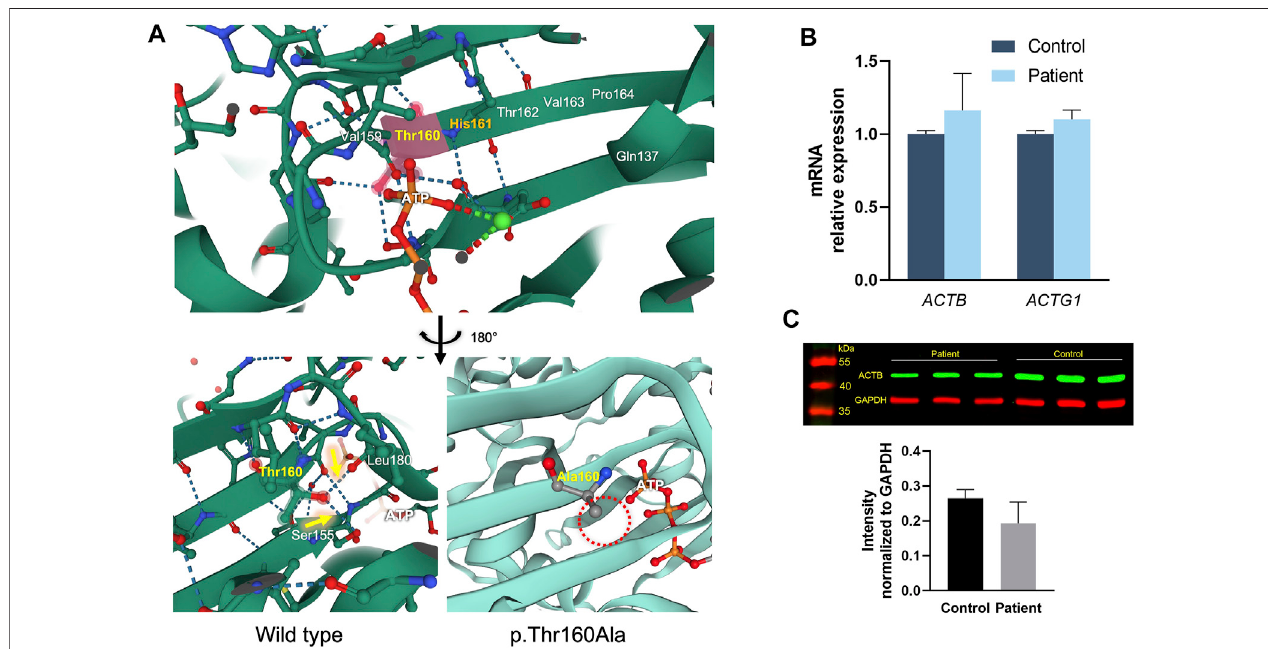
FIGURE4| ACTBproteinstructureandvariantmodeling,andexpression analysis. (A) Thr160isclosetoHis161,whichisthecatalyticbaseofATPhydrolysis. The hydroxyl group side chain of Thr160 forms hydrogen bonds with the spatially close Leu180 and Ser155 (yellow arrows), and the p.Thr160Ala variant results in alanine without a hydroxyl group in the side chain, which cannot form hydrogen bonds with the surrounding residues (dashed red circle). (B) mRNA expressions of ACTB and ACTG1 in the PBMCs of the patient and healthy controls. (C) Western blot showing that the variant does not change the ACTB protein expression in PBMCs ( p > 0.05); GAPDH was used as loading control.